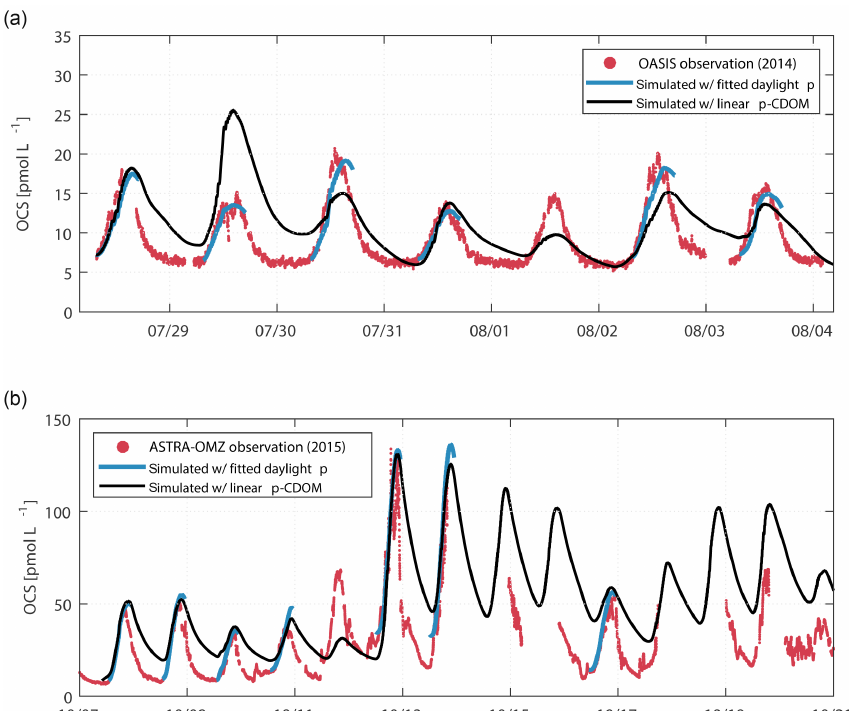
Figure 2. Box model simulations compared to observations: comparison of simulated OCS water concentrations against measurements from the OASIS cruise to the Indian Ocean (a) and the eastern Pacific Ocean during the ASTRA-OMZ cruise (b) . Blue indicates OCS concentrations with a least-squares fit for the photoproduction rate constant p during daylight, fitted individually for days with homogeneous water masses (SST, a 350 ). Black shows the simulation including the p depending on a 350 , obtained from linear regression of individually fitted p with a 350 ( r = 0.71). The time on the x axis is local time (GMT + 5 during OASIS 2014, GMT − 4 during ASTRA-OMZ 2015).